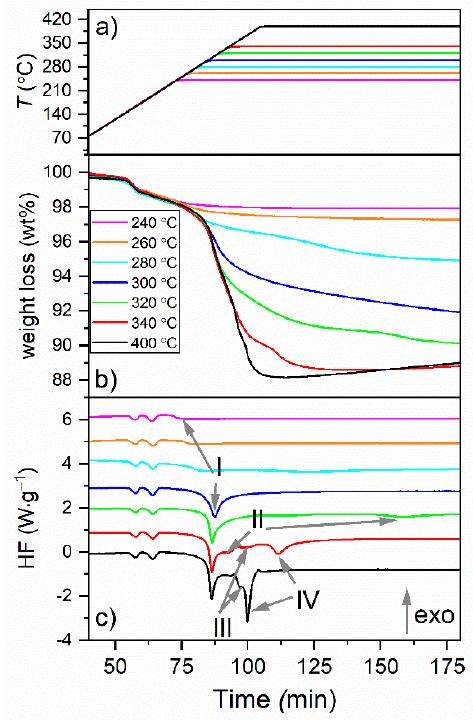
Figure 1. ( a ) Temperature, ( b ) TGA and ( c ) DSC profiles of γ -Mg(BH 4 ) 2 samples kept at different temperatures in Ar flow.